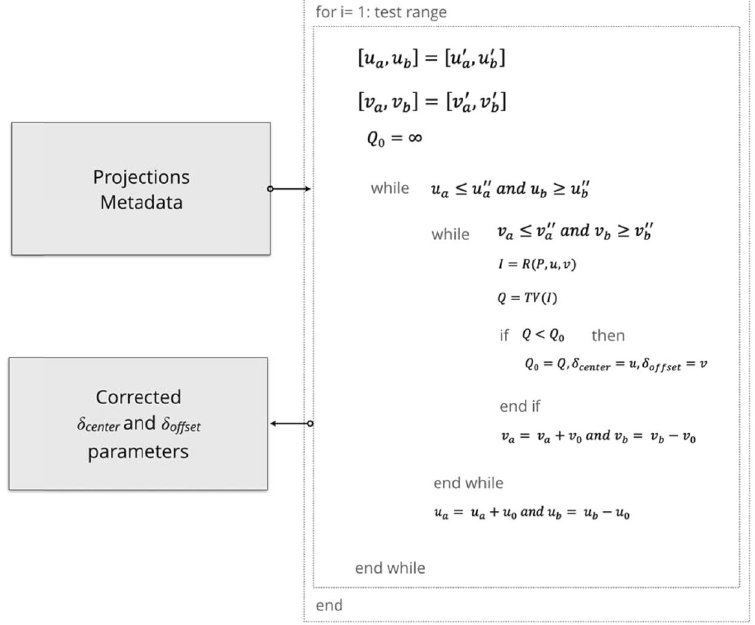
Figure 9. The implementation of the algorithm for the center of rotation and the offset of detector corrections. Subscripts a and b defines the range, and 0 means the initial point for the